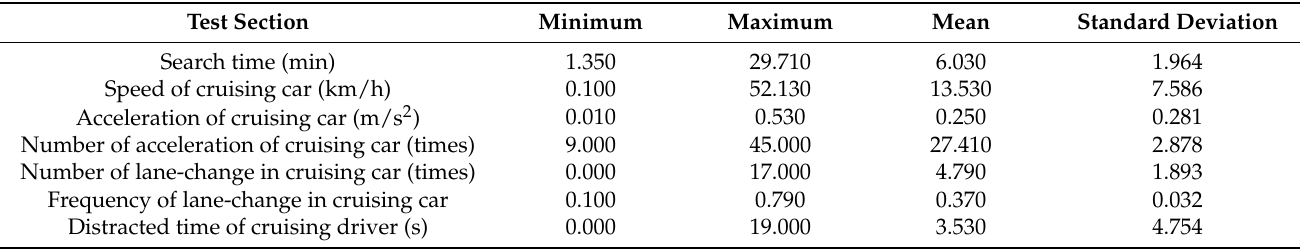
Table 1. Characteristics of Test Sections.